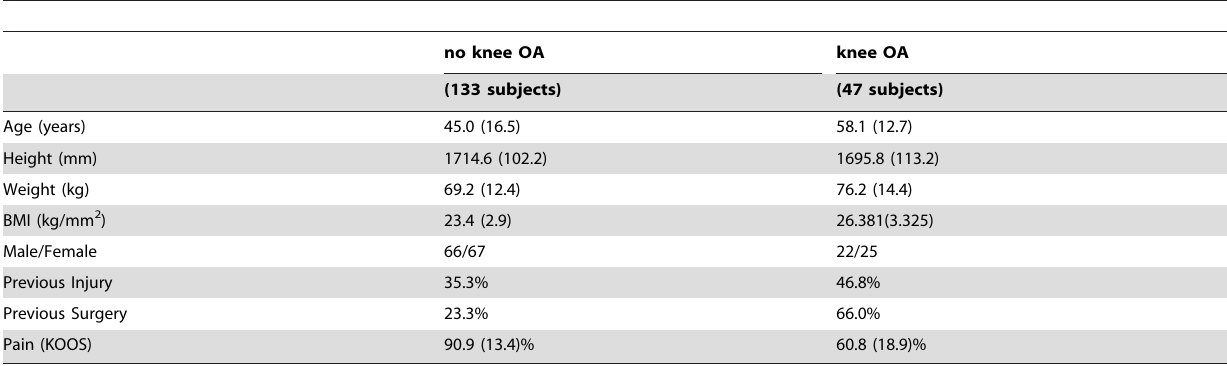
Table 1. Mean value and standard deviation about the age, height, weight, BMI, sex, and pain (as assessed by the KOOS score) and the number of subjects that have experienced a surgery or an injury for both the control and the knee OA